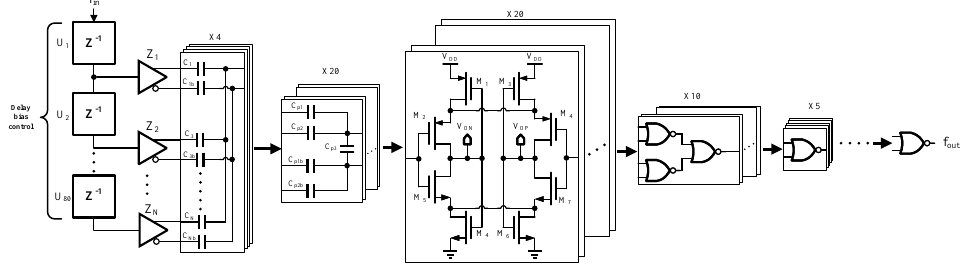
Figure 11. System schematic of the proposed clock